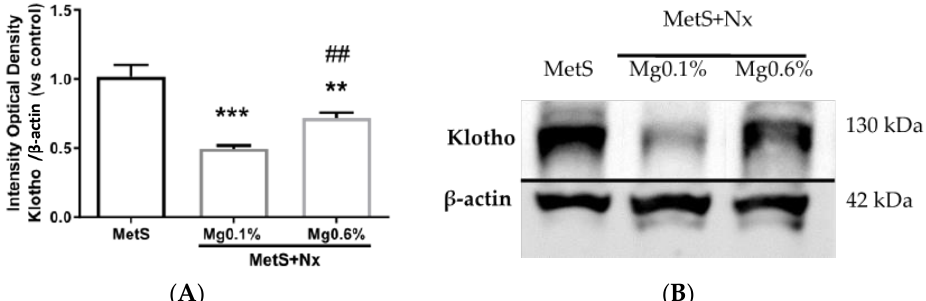
Figure 1. Dietary Mg supplementation prevented a decrease in renal Klotho expression in rats with metabolic syndrome and 5/6 nephrectomy. Nx rats were fed a normal (0.1%) Mg diet or received a dietary Mg supplementation (0.6%). Sham-operated rats fed a normal P and Mg diet served as controls. ( A ) Image J software was used to quantify renal Klotho expression obtained by western blotting in all animals from the study (n = 10 animals per group). ( B ) Western blot bands were cropped showing each experimental group, choosing the animal with the most approximated value to the mean of the group obtained after Image J quantification. Data expressed as mean ±